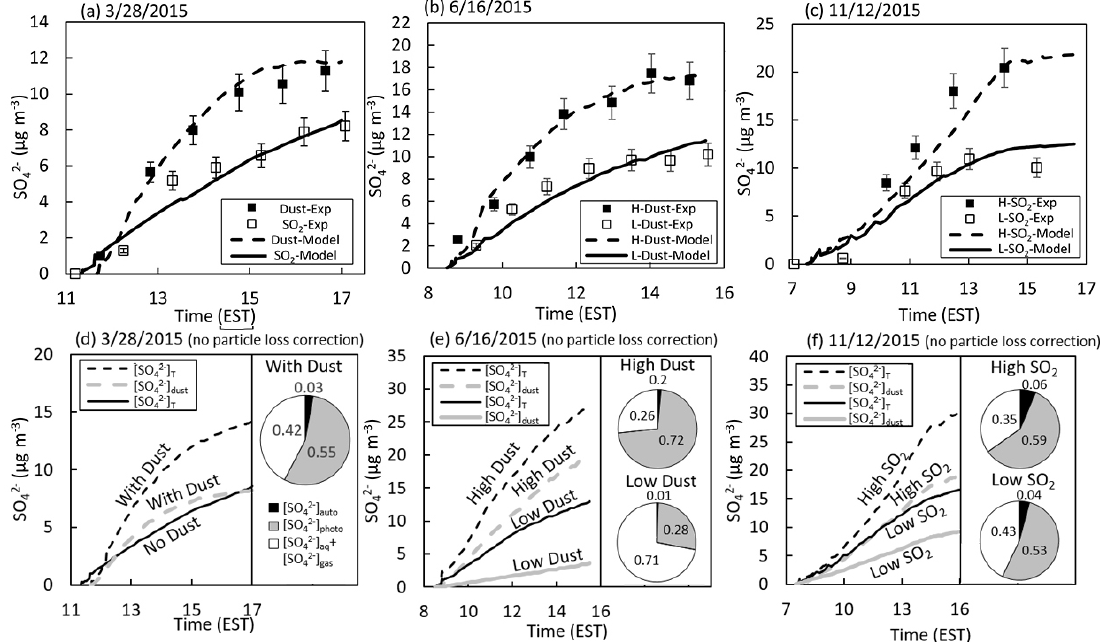
Figure 3. Time profiles of total sulfate concentration (SO 2 − ,µgm − 3 ) in the UF-APHOR. “Exp” denotes the experimentally observed sulfate 4 ([SO 2 − ] T ) and “Model” denotes the model-predicted sulfate. “H” and “L” represent the high and the low initial concentrations of chemical 4 species. The errors associated with the concentration of sulfate is ± 10% originated from the PILS-IC measurement. (a) Sulfate formation with and without ATD particles (SO 2 60ppb vs. SO 2 56ppb and dust 290µgm − 3 ) . (b) The high and low loadings of dust particles (dust 90µgm − 3 and SO 2 100ppb vs. dust 404µgm − 3 and SO 2 120ppb). (c) The high and the low concentrations of SO 2 (SO 2 119ppb and dust 239µgm − 3 vs. SO 2 272ppb and dust 230µgm − 3 ) . For (a) , (b) , and (c) , the simulations included the chamber dilution and the wall process of gaseous compounds and particles (Sect. S1). For (d) , (e) , and (f) , the wall process for the particle loss was excluded to estimate the influence of ATD particles on sulfate formation without the chamber artifacts. In (d) , (e) , and (f) , total sulfate was decoupled into the sulfate originated from dust chemistry ([SO 2 − ] dust = [SO 2 − ] photo + [SO 2 − ] auto ) . The pie charts inserted into (d) , (e) , and (f) illustrate how 4 4 4 total sulfate is attributed to major pathways at the end of the